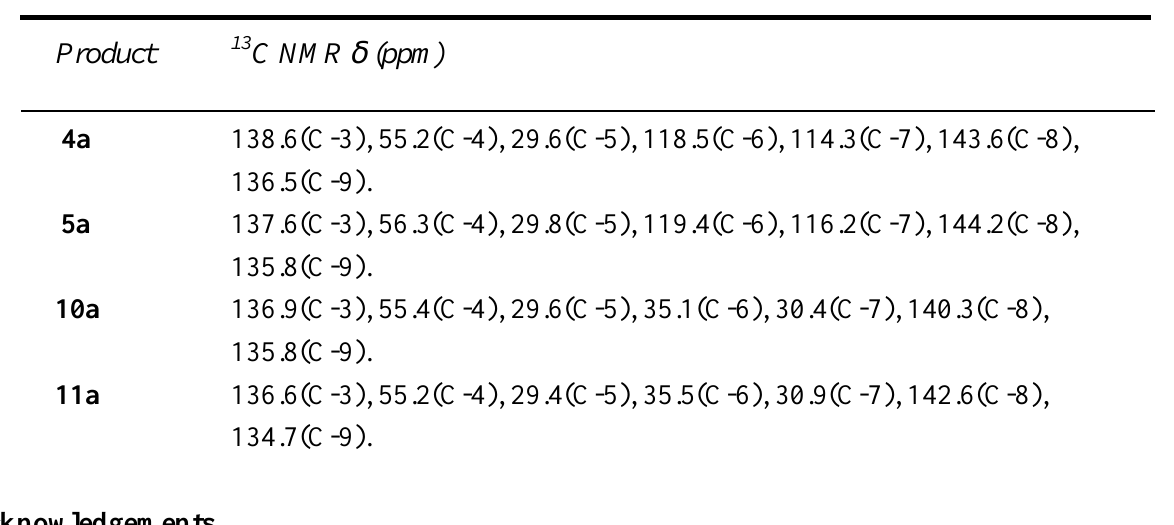
Table 3. 13 C-NMR Spectral Data of 4a, 5a, 10a and